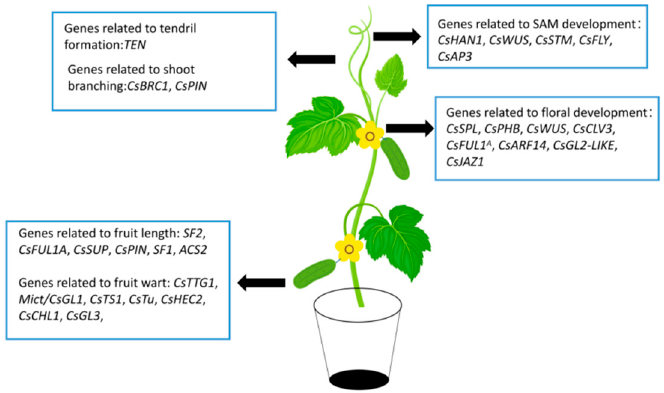
Figure 3. Illustration of agronomic trait-related genes in cucumber plants.